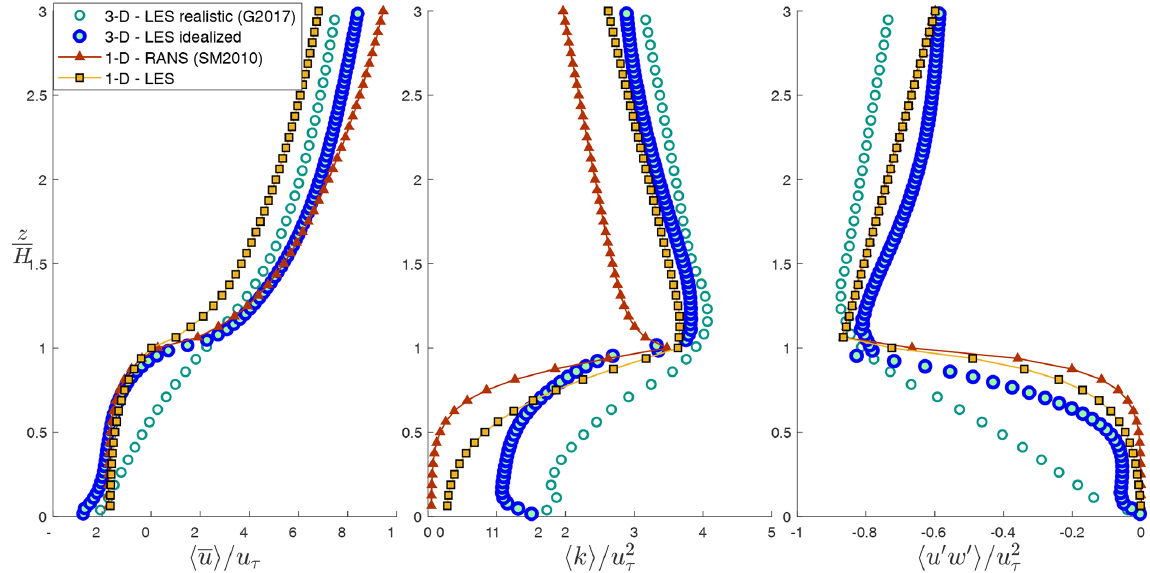
(cid:16) (cid:17) (cid:104) k (cid:105) /u 2 , and turbulent momentum flux τ